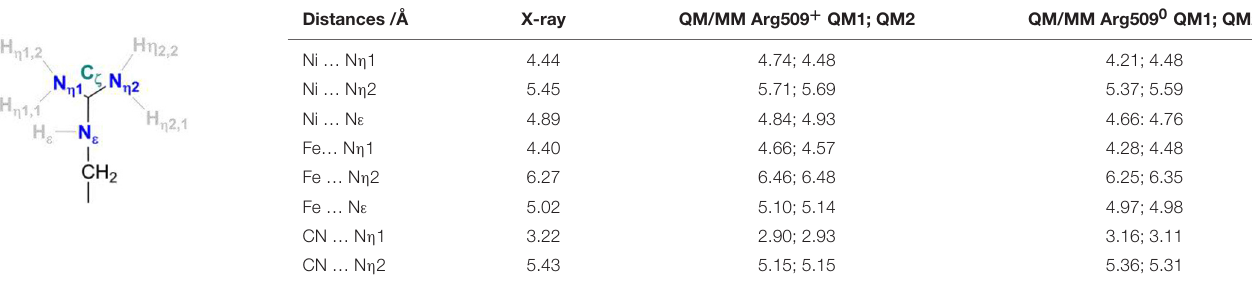
FIGURE 3 | (A) QM regions (QM1-QM4) used in the QM/MM calculations. QM/MM boundary (C α -C β ) atoms are shown in orange. Reaction mechanisms investigated in this study are indicated in arrows; a unique color is used for each mechanism (e.g., black arrows are used to highlight an R509 + -assisted H 2 activation). (B) Representative structure of the simulation system. The active region in the QM/MM calculations is enlarged at the bottom with the atoms of the QM1-QM4 regions highlighted. See the text for more details.